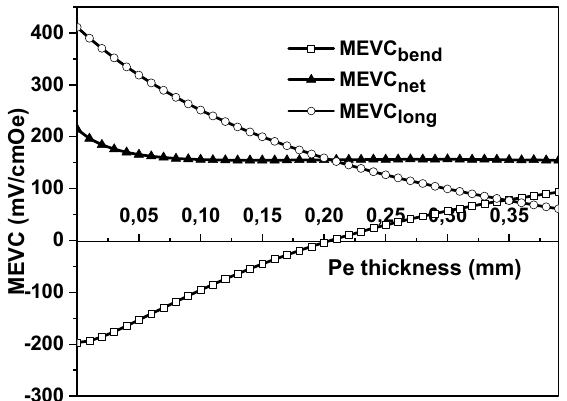
Figure 7. Estimated dependence of MEVC in a Ni-PZT-Permendur first-type three-layered structure on the Permendur layer thickness. The PZT layer thickness t p = 0.2 mm, the Ni thickness t m 1 = 0.2 mm.